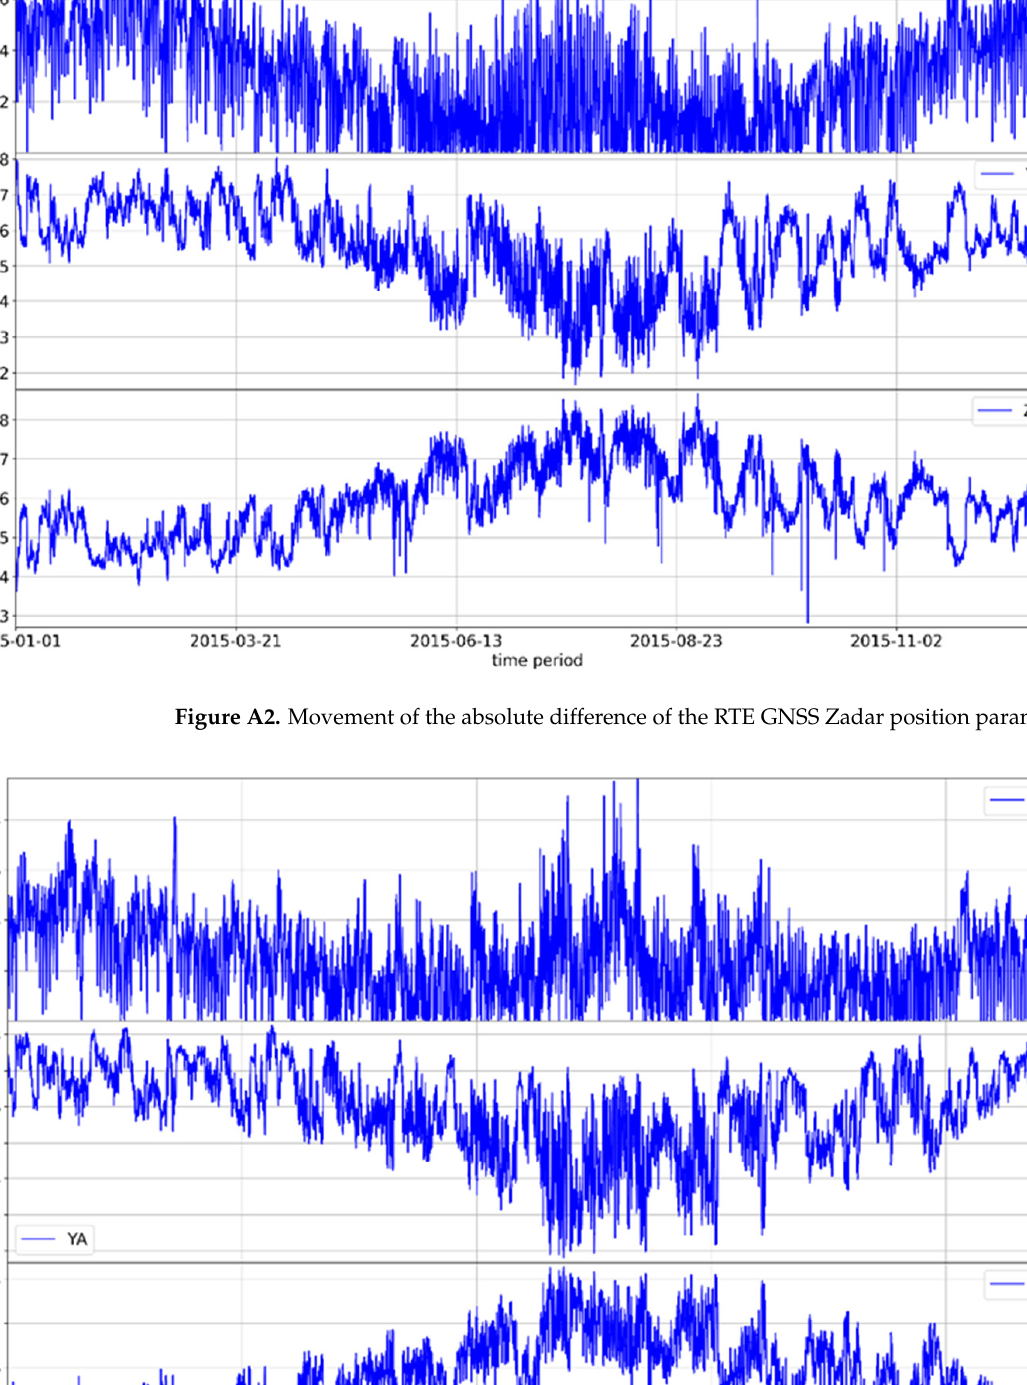
Figure A1. Movement of the absolute difference of the RTE GNSS Čakovec position parameter in 2015.